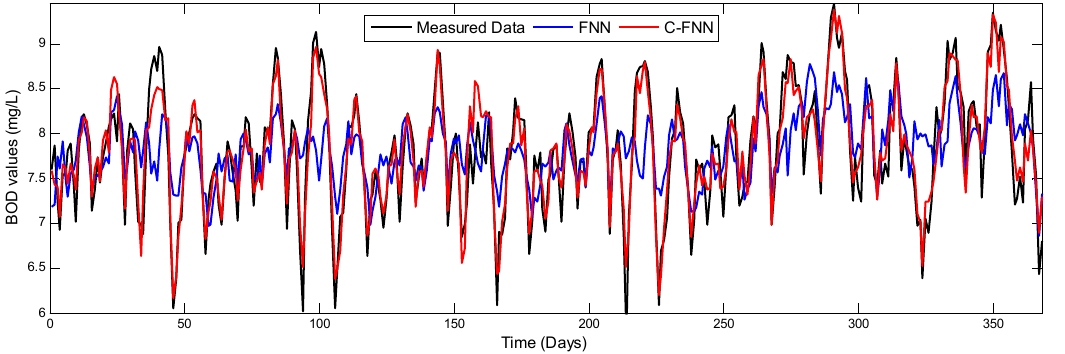
Figure 10. The training output of the FNN, C ‐ FNN for BOD.